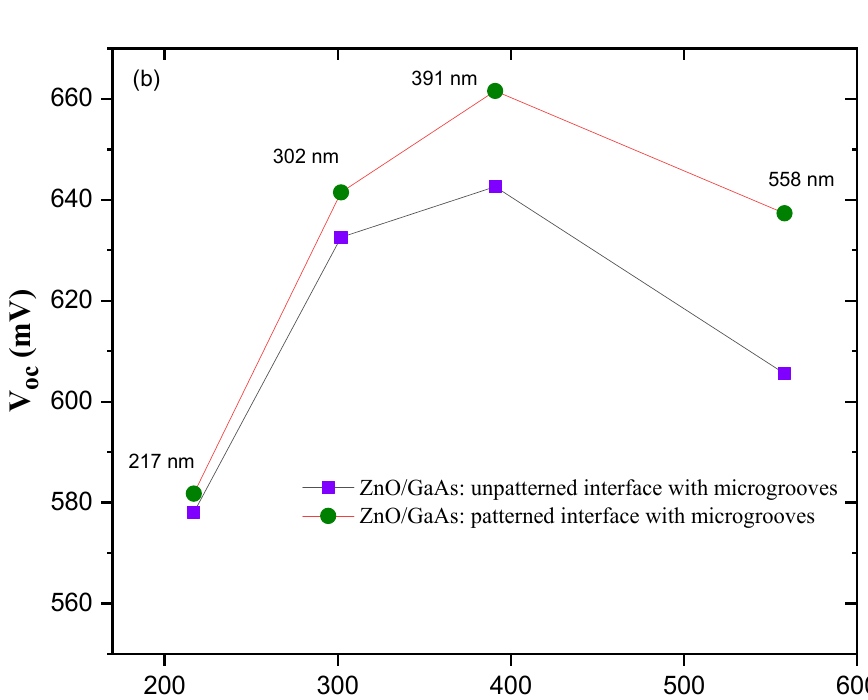
Figure 8. The effect of ZnO emitter thickness on the ( a ) J sc and ( b ) V oc , highlighting the vital role of microgrooves at the heterojunction interface.